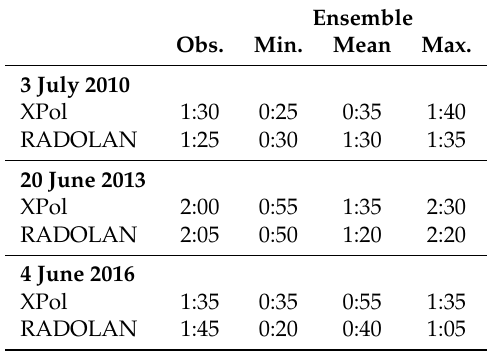
Table 5. ParFlow hindcast basin response times for flood events. Ensemble Obs. Min. Mean